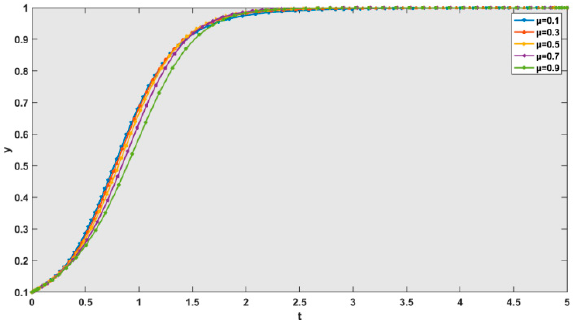
Figure 8. The influence of the change of